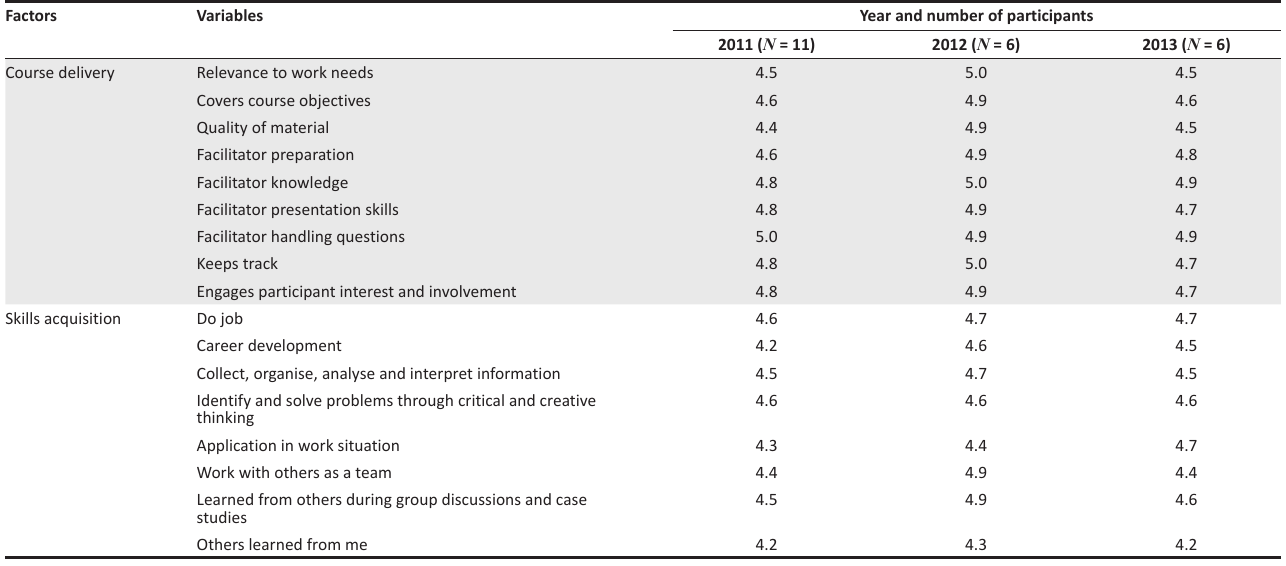
TABLE 4: Participant reactions on course delivery. Factors